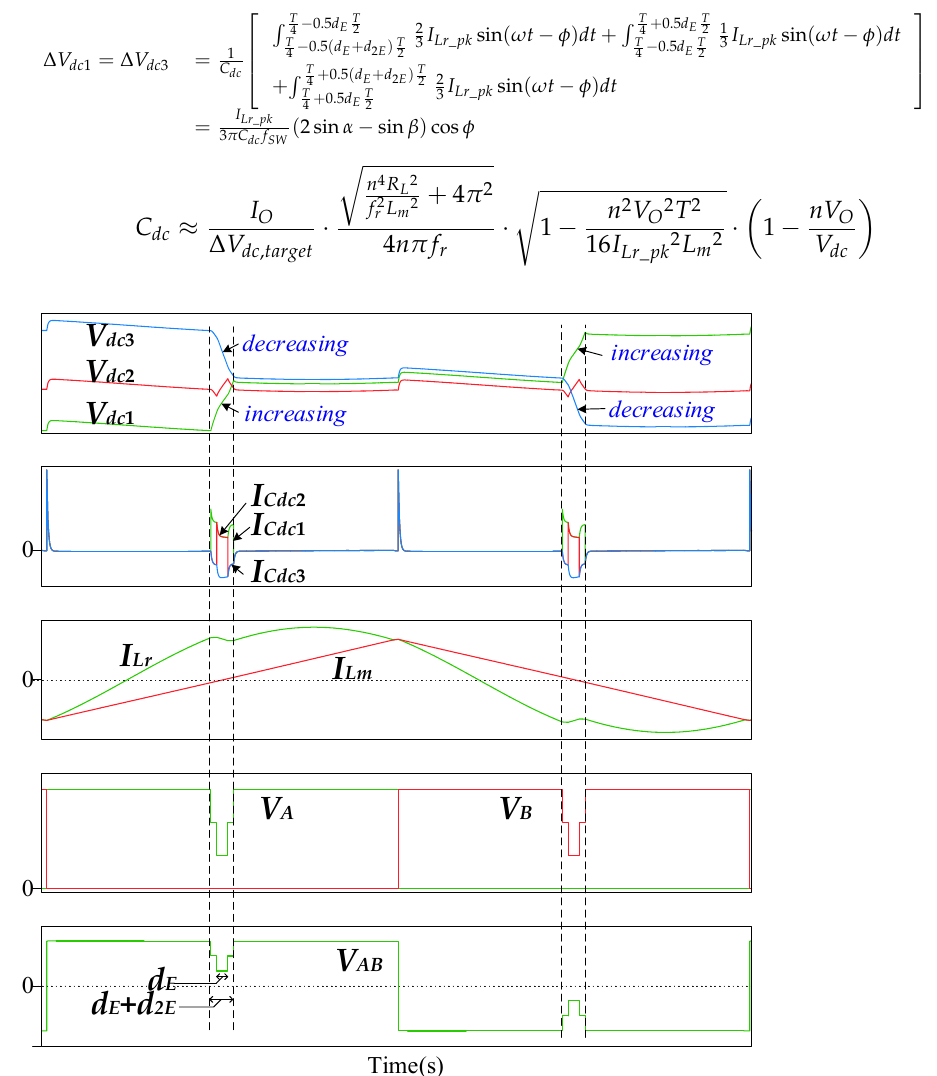
Figure 13. Voltage change characteristics of DC link capacitors in the LCM. The output capacitor current I CO in the steady state, assuming a continuous current mode, is shown in Figure 14. Because I CO equals the output diode current ( I DO 1 or I DO 2 ) minus I O , the net charge increment of C O and Q CO from t 1 and t 2 , respectively, is calculated using Equation (21). Here, t 1 = sin − 1 (2/ π )/ ω , t 2 = [ π -sin − 1 (2/ π )]/ ω . Thus, to satisfy the target output voltage fluctuation range ∆ V Co,target , C O is determined by Equation (22).